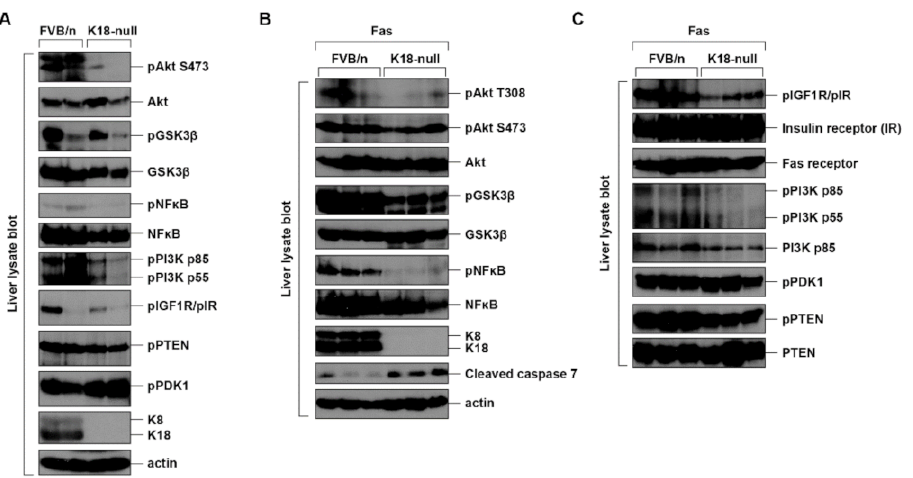
Figure 4. K8/K18 expression protects mouse liver from apoptosis by upregulation of Akt signaling pathway. ( A ) Livers from nontransgenic FVB/n and K18-null mice were harvested. The liver lysates were immunoblotted with the indicated antibodies. Sex- and age-matched mice were used, and each lane represents the result of one individual mouse liver. ( B , C ) Sex- and age-matched nontransgenic FVB/n or K18-null mice were treated with Fas (0.15 µ g/g body weight) for 4 h to induce liver damage. The liver lysates were immunoblotted with the indicated antibodies. Each lane represents the result of one individual mouse